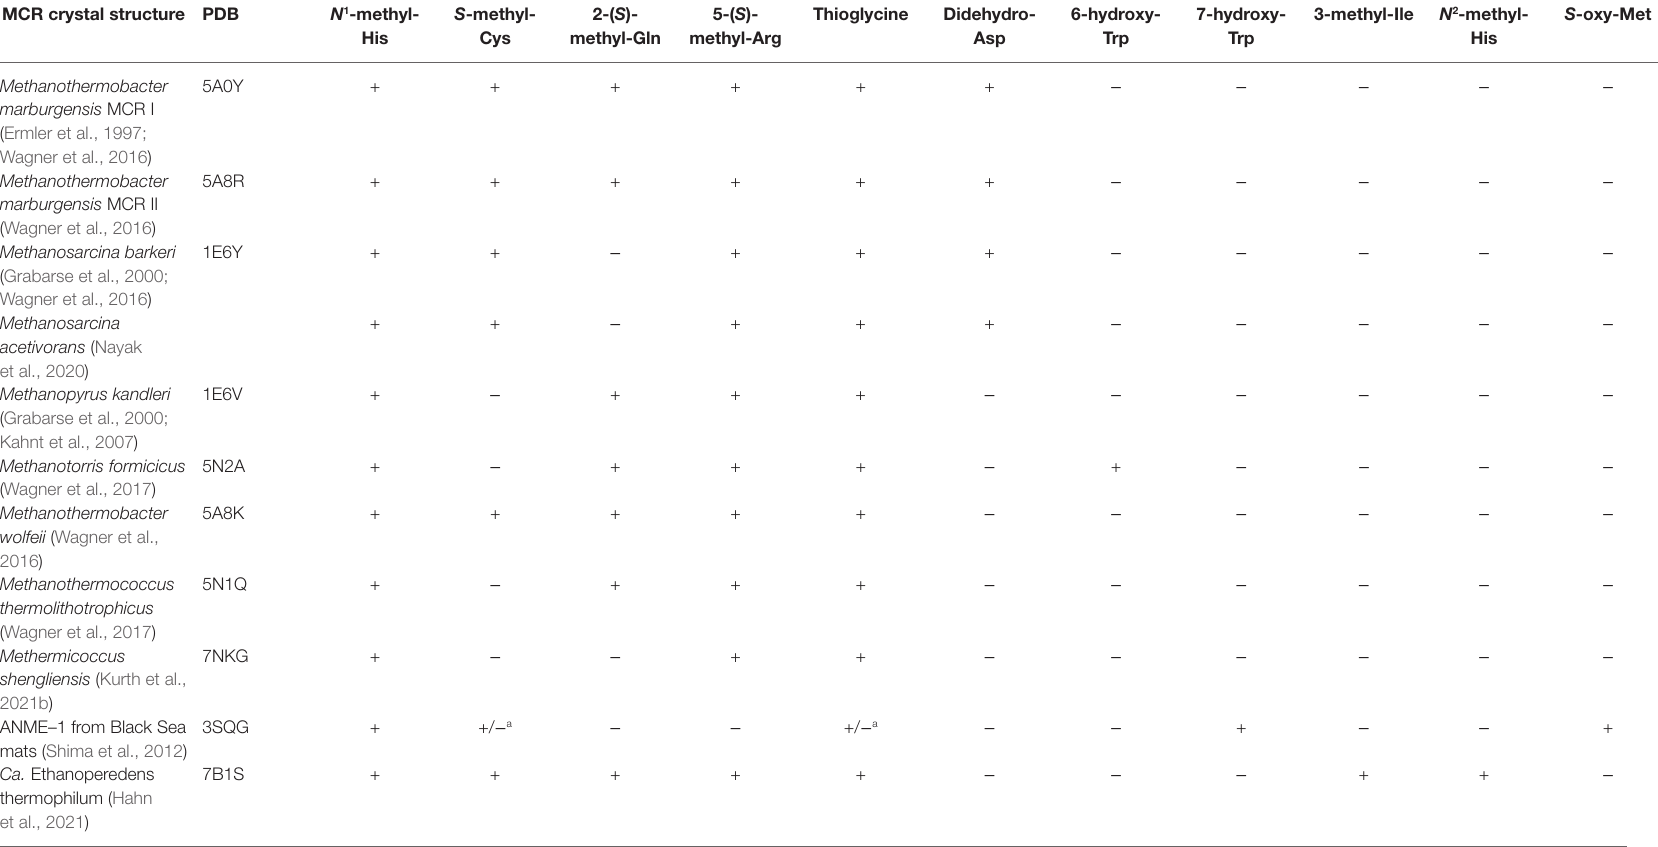
TABLE 1 | Summary of MCR crystal structures with associated PTM content. MCR crystal structure PDB N 1